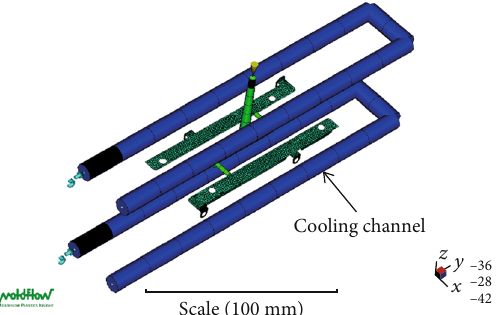
Figure 4: A meshing model for numerical simulation (Mold fl